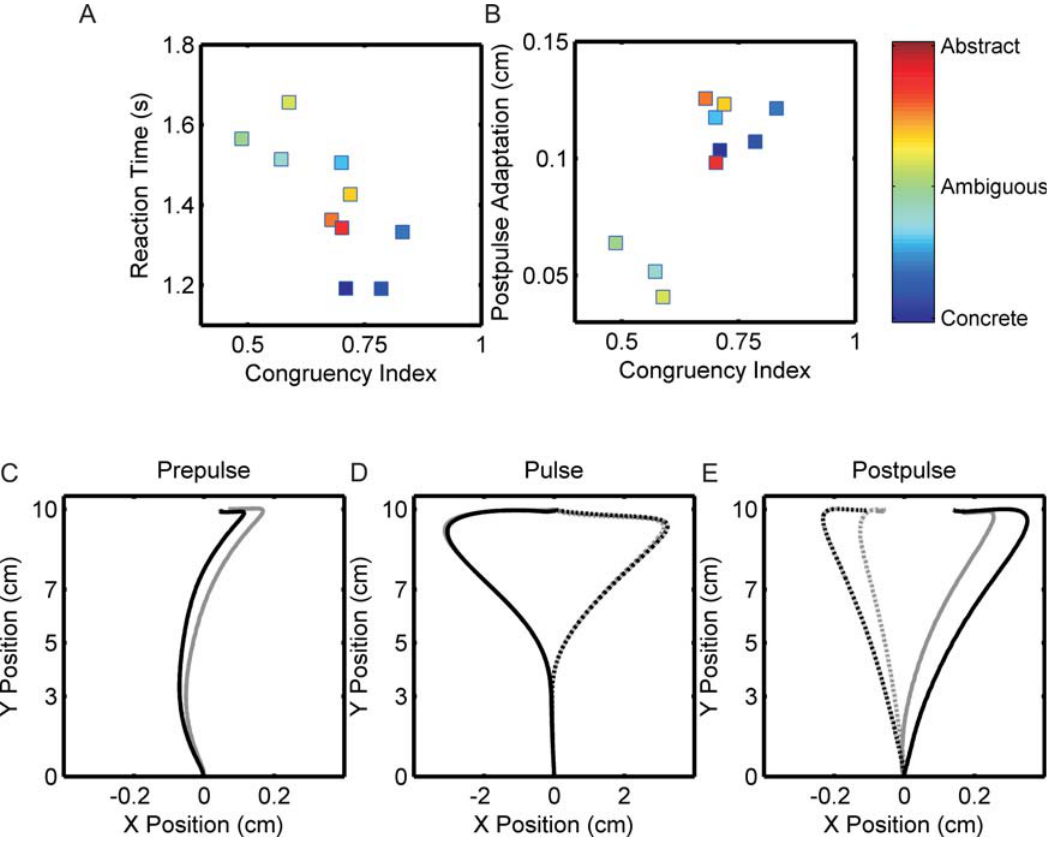
Figure 4. Decision-level uncertainty measured by comparisons of online to offline word categorization. The congruency index measured the similarity of word categorization from online to offline categorization across subjects. For each subject, words that maintained categorization were assigned a 1 and words that were switched were given a zero. Averaged across subjects, words were grouped into 10 equally sized bins dependent on congruency index. Colorbar (side) represents the linear spectrum of subjects’ offline word survey of concreteness from most concrete (blue) to most abstract (red). A) The greater the congruency index (maintained categorizations), the faster the RT. These congruent words were words that best fell into either concrete or abstract categories during the offline word survey. B) The postpulse adaptation correlates with the congruency index. Subjects adapted more on congruent words (index closer to 1), than on incongruent words (closer to 0). C) Average movement trajectory preceding pulsed movements with either low congruency indices (gray), less than the mean congruency index, and movements with high congruency indices (black), greater than the mean congruency index. D) Average pulse movement trajectory for low (gray) and high (black) congruency index words for leftward (solid) and rightward (dashed) force perturbations. E) Average postpulse movement trajectory, minus average prepulse movement trajectory, following leftward (solid) and rightward (dashed) pulsed movements with low (gray) and high (black) congruency index words.